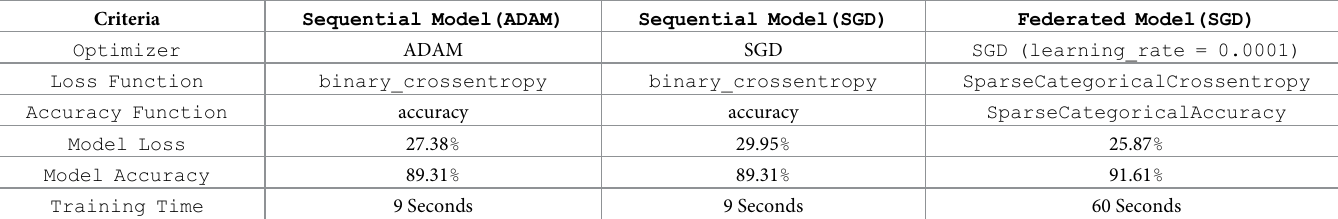
Table 1. Comparison between proposed models accuracy and loss on patient’s descriptive COVID-19